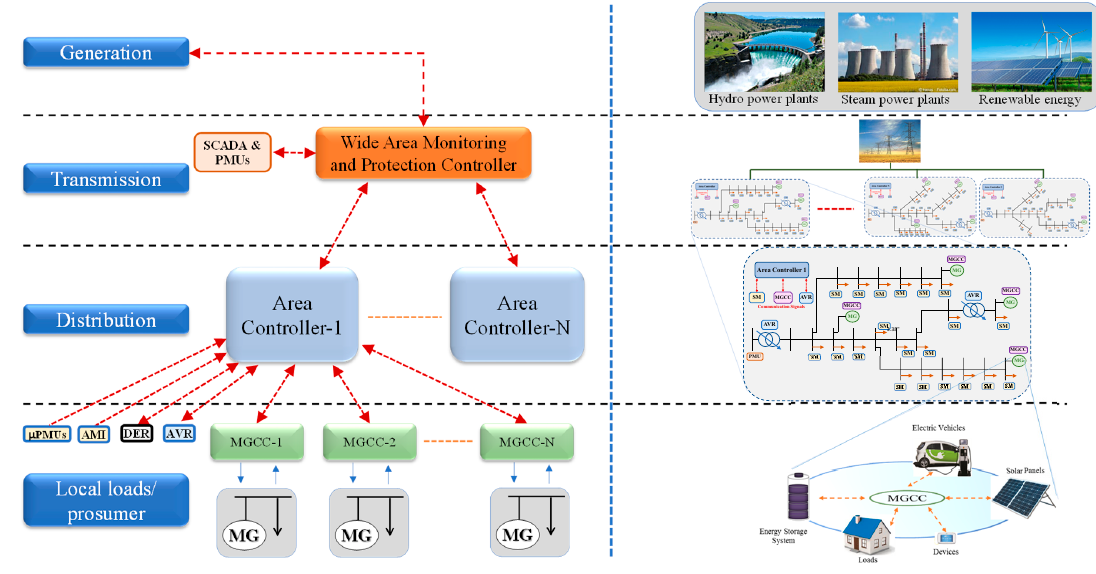
Figure 2. Envisioned smart grid: ( Right ) centralized control hierarchy and ( Left ) the infrastructure evolution.